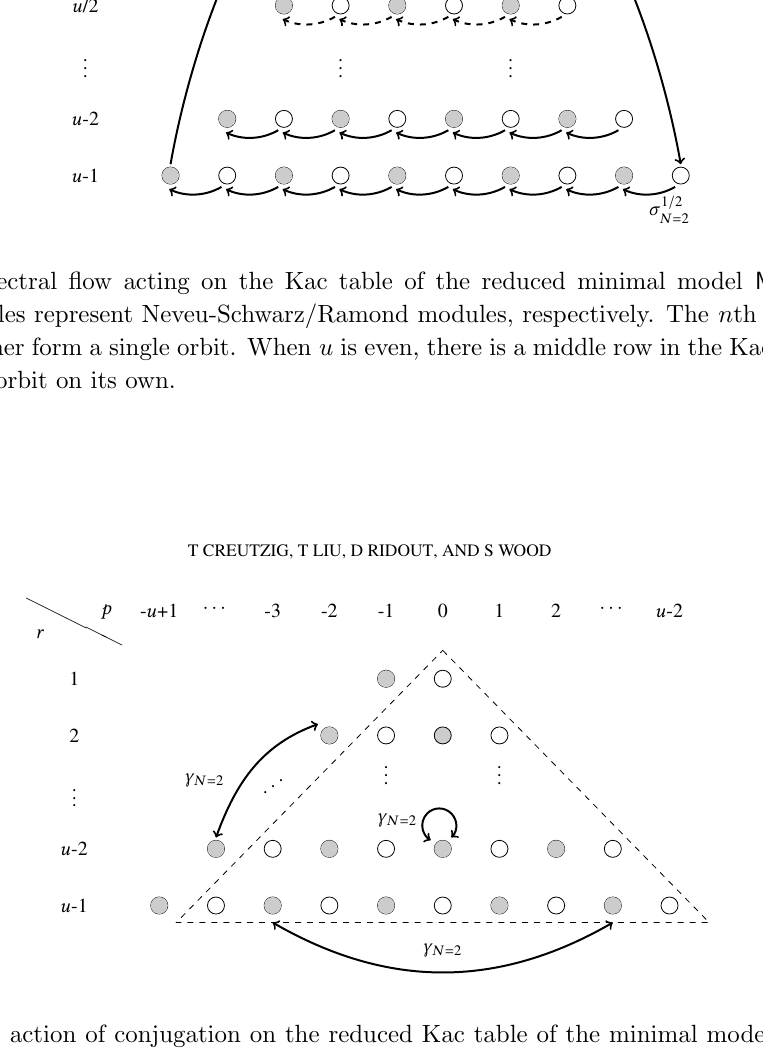
Figure 2 . The action of conjugation on the reduced Kac table of the minimal model M ( u; 1). In Figure 2. The action of conjugation on the reduced Kac table of the minimal model M the dashed triangle, conjugation is effected by reflection about the central column ( p = 0). The the dashed triangle, conjugation is e(cid:11)ected by re(cid:13)ection about the central column ( p = 0). The modules outside this triangle form a strip on which conjugation is effected by reflection about the modules outside this triangle form a strip on which conjugation is e(cid:11)ected by re(cid:13)ection about the strip’s middle point. strip’s middle